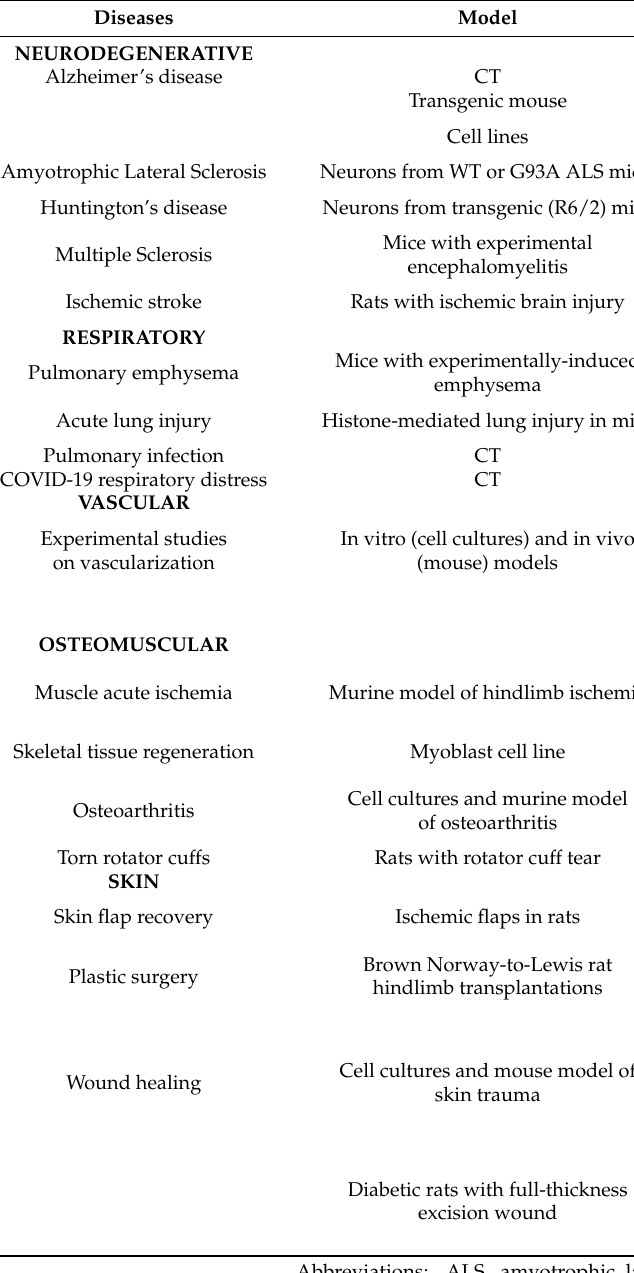
Table 1. Some of the experimental uses of EVs derived from ASCs for clinic